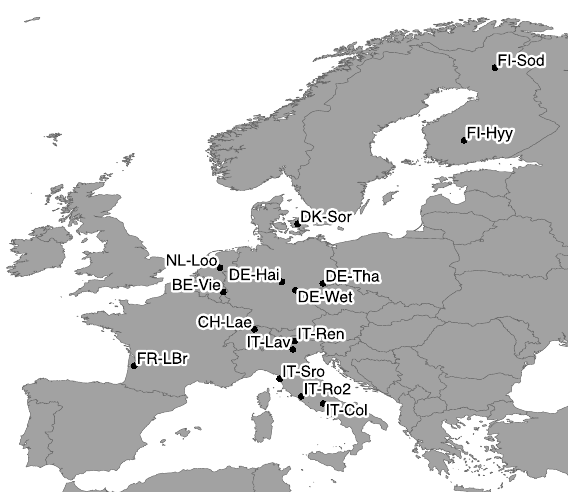
Figure 2. Map of the 15 FLUXNET sites used in this study. Base map elements from Natural